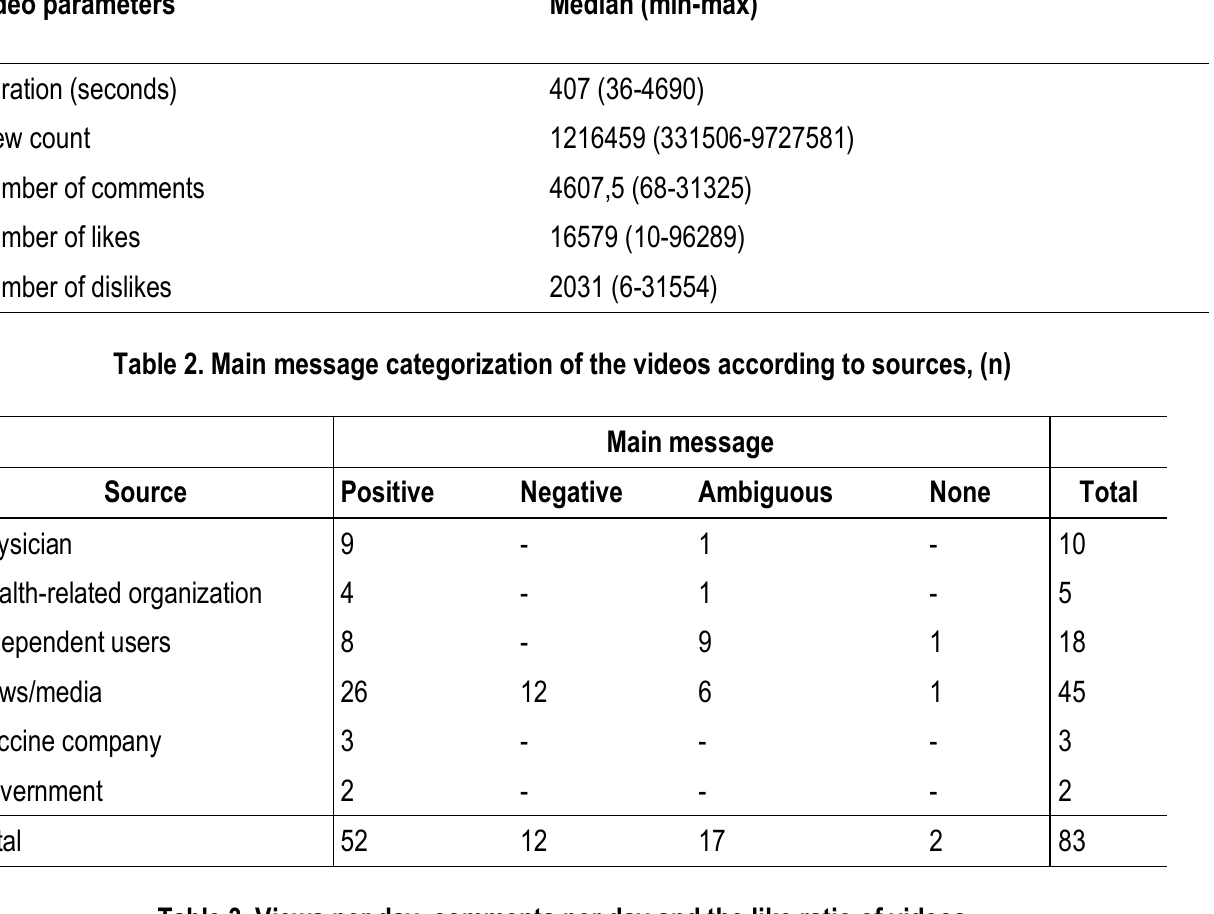
Table 3. Views per day, comments per day and the like ratio of